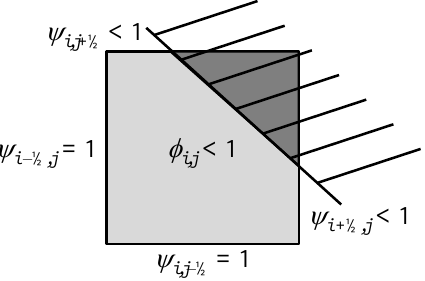
Figure 15. Storage porosity φ defined for each cell ( i , j ) of the two-dimensional grid and conveyance porosities ψ defined at the four faces of each grid